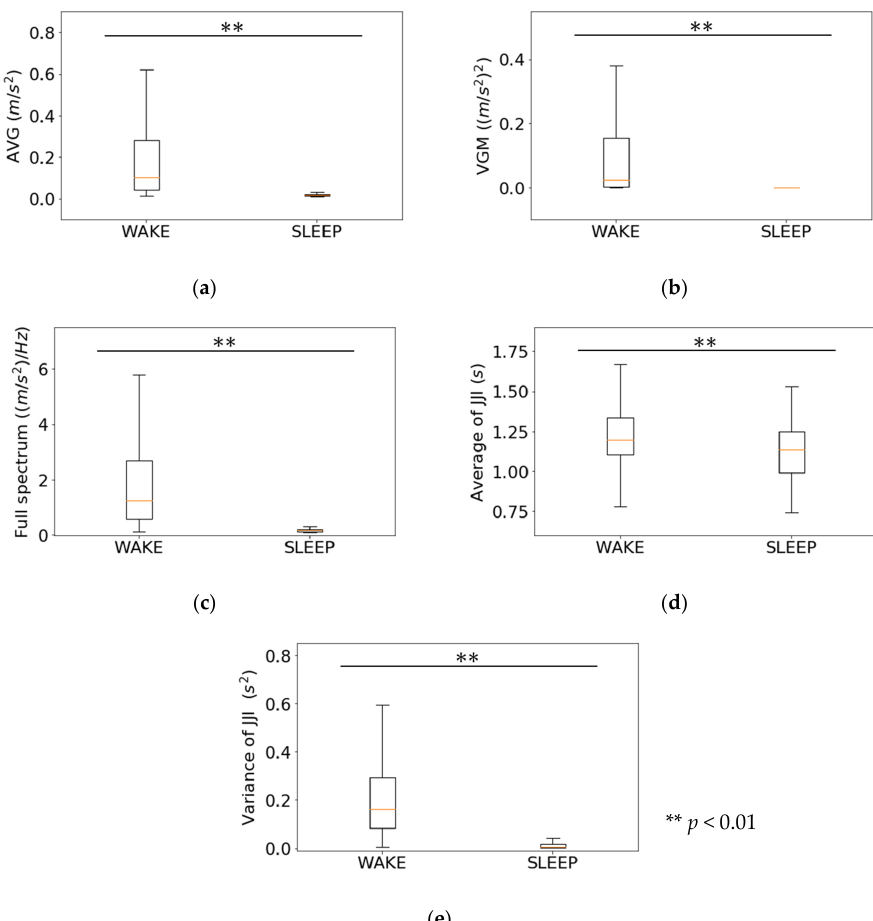
Figure 7. Wilcoxon signed-rank test results for the first-step features: ( a ) Average of gross movements; ( b ) Variance of gross movements; ( c ) Full spectrum; ( d ) Average of JJI; ( e ) Variance of JJI.